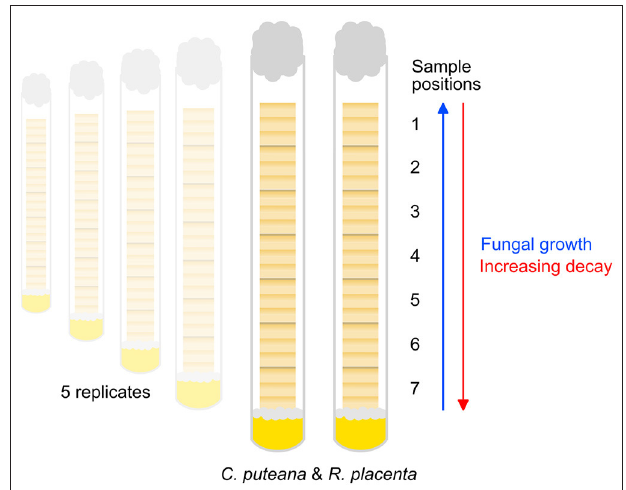
FIGURE 1 | Outline of the decay test set-up. Seven samples (sample position 1–7) were stacked in test tubes over nutrient agar inoculated with C. puteana or R. placenta . The fungi colonized the samples progressively, producing a series of samples in different stages of decay.